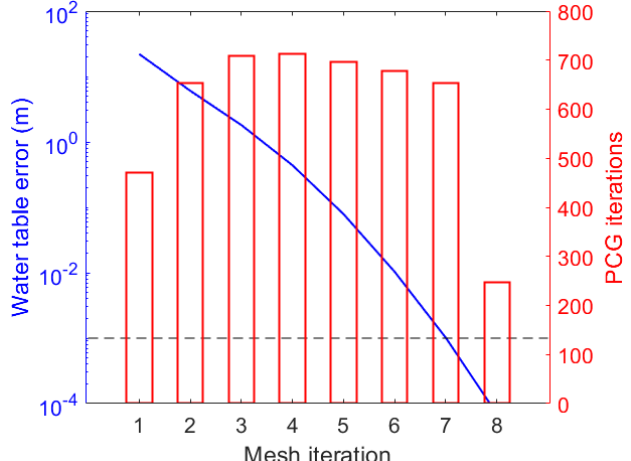
Figure 9. Performance of the adaptive mesh iteration for the fourth test problem. The water table error decreases with a rate greater than a linear trend. The bars show the number of linear iterations at each outer iteration. Eight mesh iteration steps were sufficient to achieve accuracy with a 10 −3 m closure criterion.